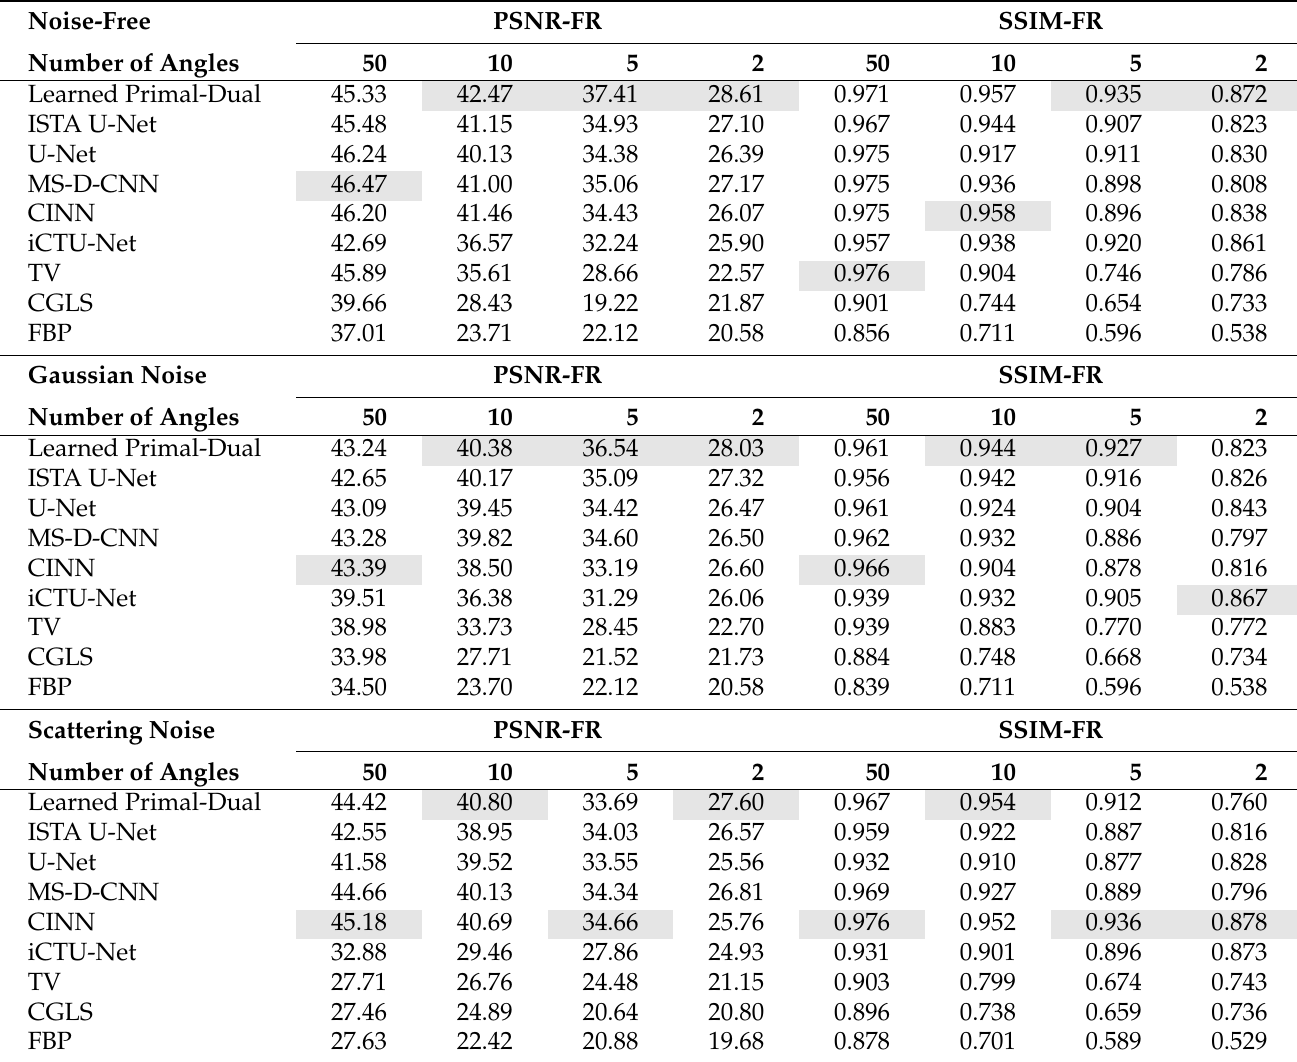
Table A4. PSNR-FR and SSIM-FR (computed with fixed data range 0.0129353 for all images) for the different noise settings on the 100 selected Apple CT test images. Best results are highlighted in